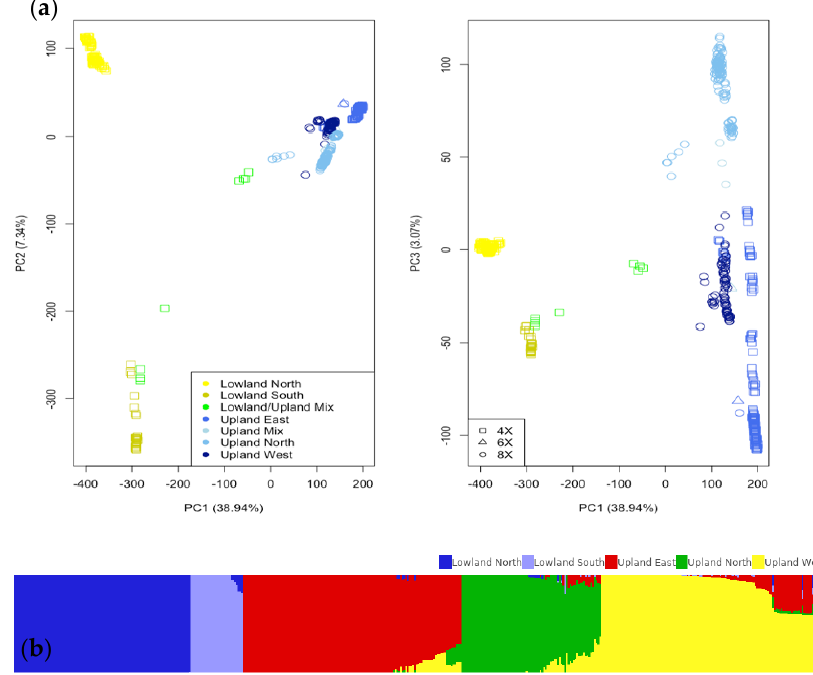
Figure 3. ( a ) The 478 switchgrass genotypes from the Northern Association Panel showed the different distributions based on ecotype and region from principal component analysis (PC). Colors represented different ecotypes, and shapes represented different ploidy levels. Percentage variances explained by PCs were in parentheses. The lowland ecotype can be differentiated into two regions from PC1 and PC2, and the upland ecotype can be grouped into three regions from PC1 and PC3. ( b ) Admixture also showed the separations of the genotypes into five gene pools.